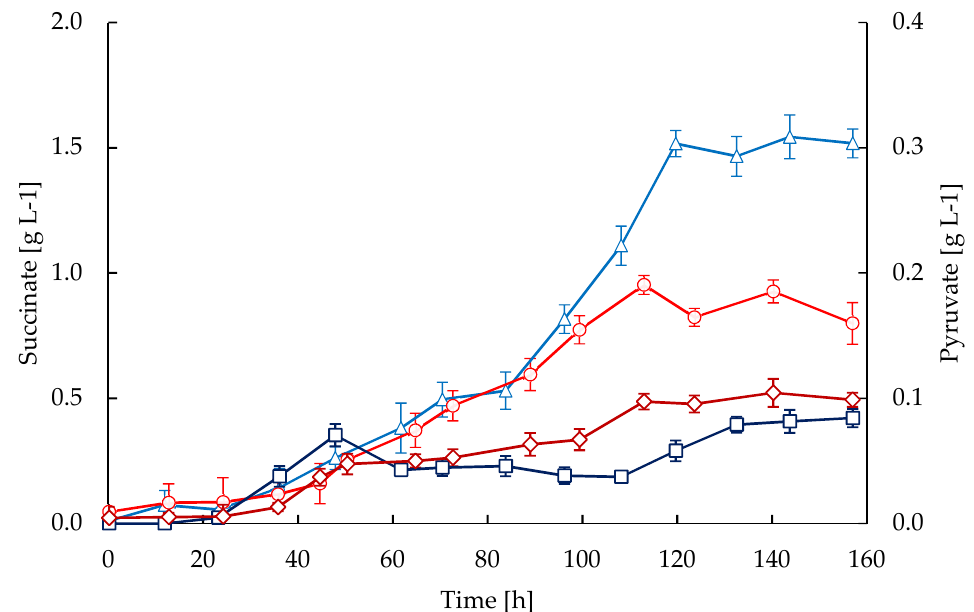
Figure 6. Time courses of succinate and pyruvate accumulations in fed-batch cultivations of S. clavuligerus. Succinate in STR (triangles) and CT (circles), pyruvate in STR (squares) and CT (diamonds).